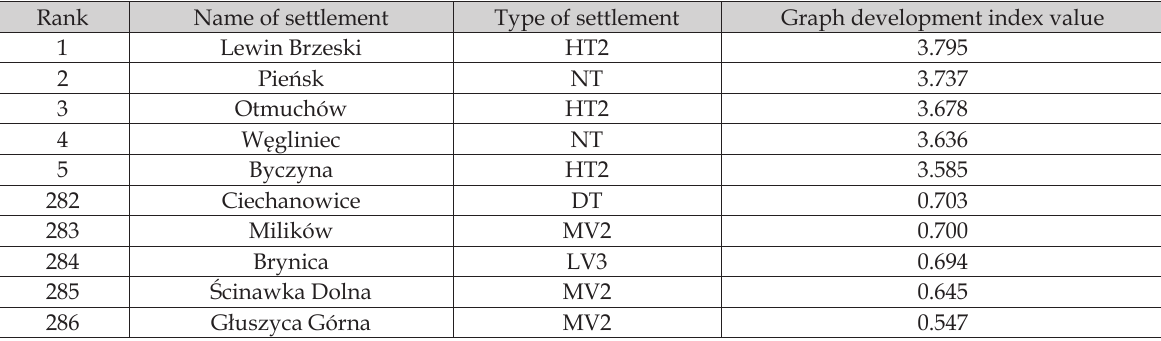
of graph development index (G ). D